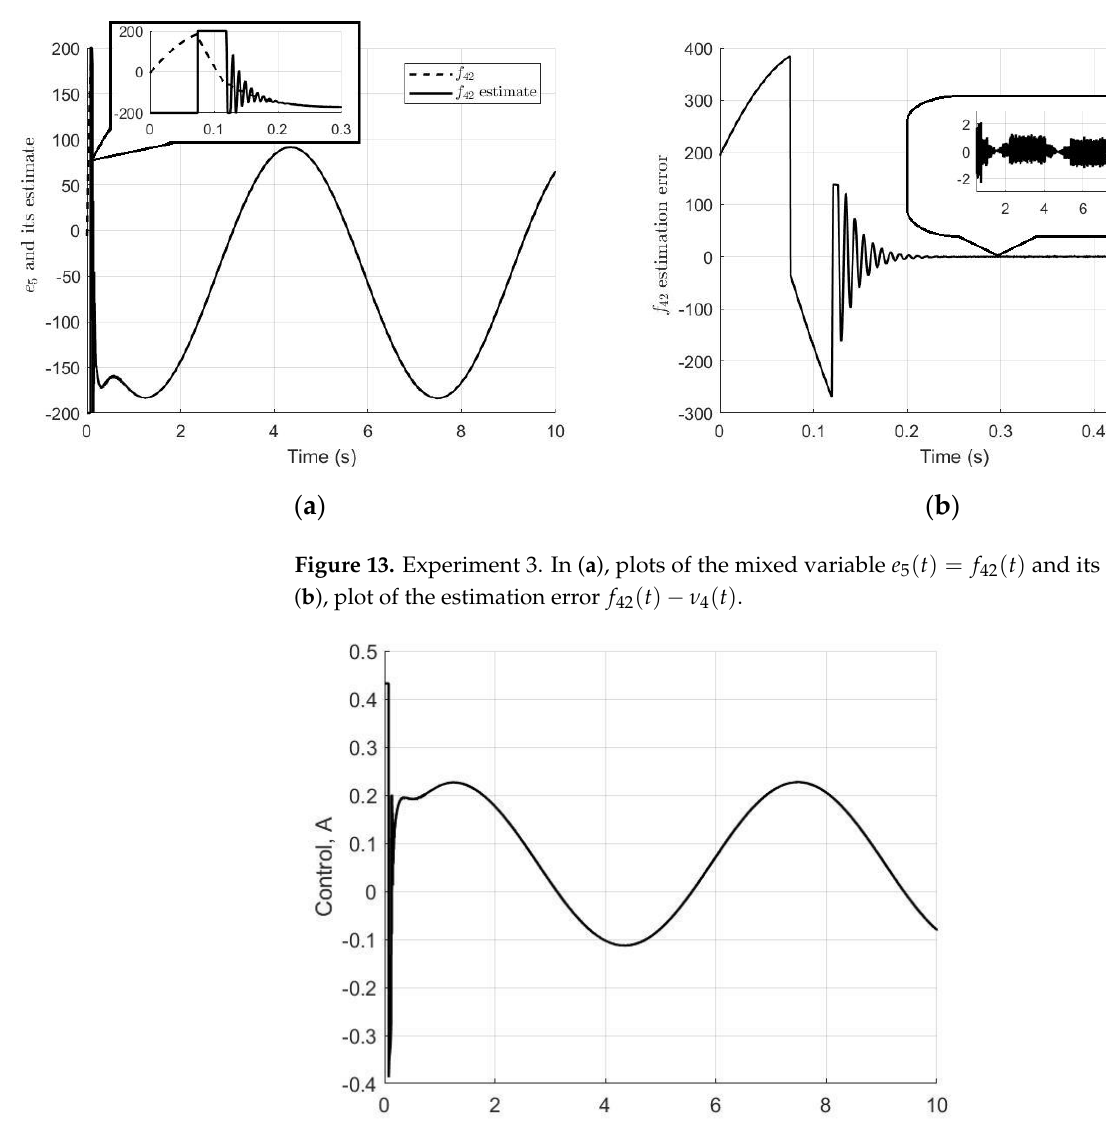
Figure 14. Experiment 3. Plot of the control u ( t ) Table 2. Values of performance indicators of closed-loop systems. Indicator